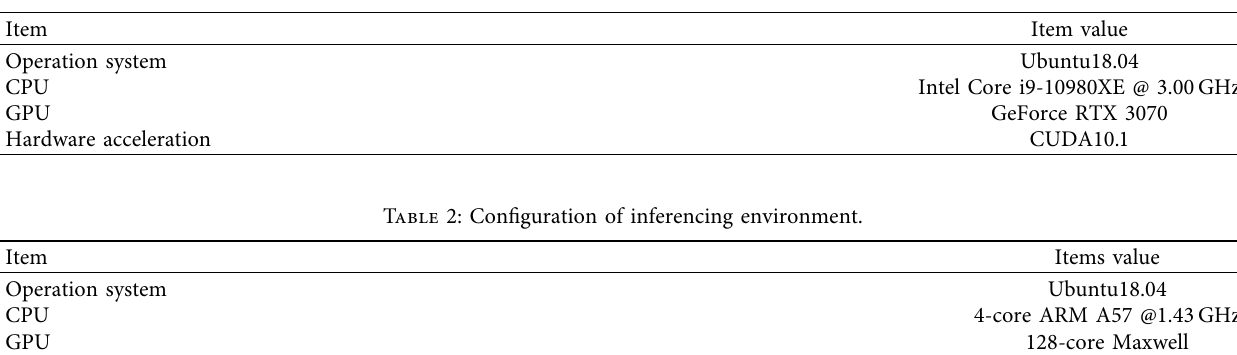
Figure 5: Improved YOLOv5 network. Table 1: Configuration of training environment.